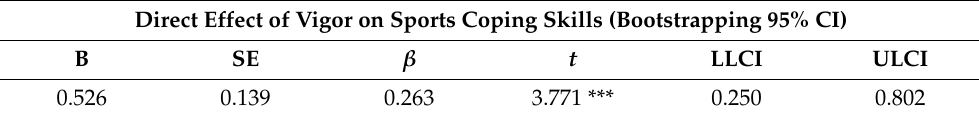
Table 8. Direct effect and conditional indirect effect of vigor on sports coping